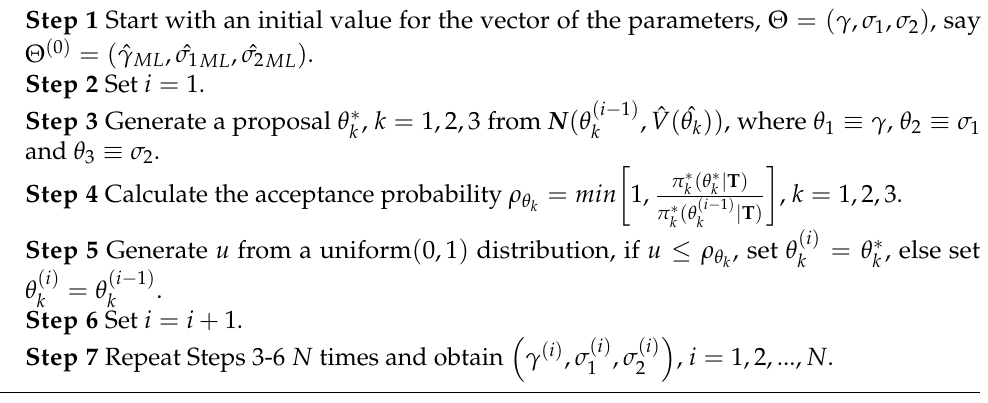
Algorithm 1 MCMC